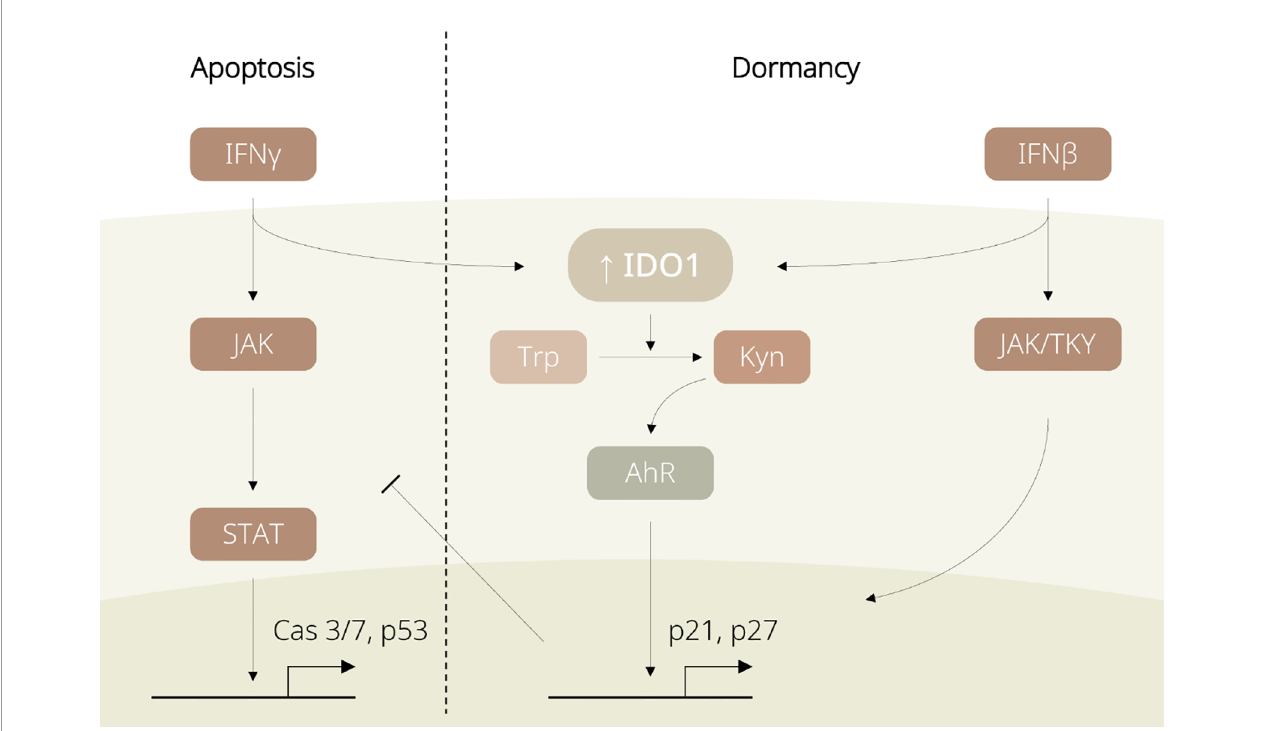
FIGURE 2 | Diagram displaying regulation of IDO1-associated dormancy by IFN family members. IFN- g induces apoptosis in non-tumour repopulating cells (non- TRCs) via the JAK/STAT pathway. In TRCs, IFNs favour the IDO1/Kyn/AhR pathway and promote p27 expression, leading to cell cycle arrest and tumour